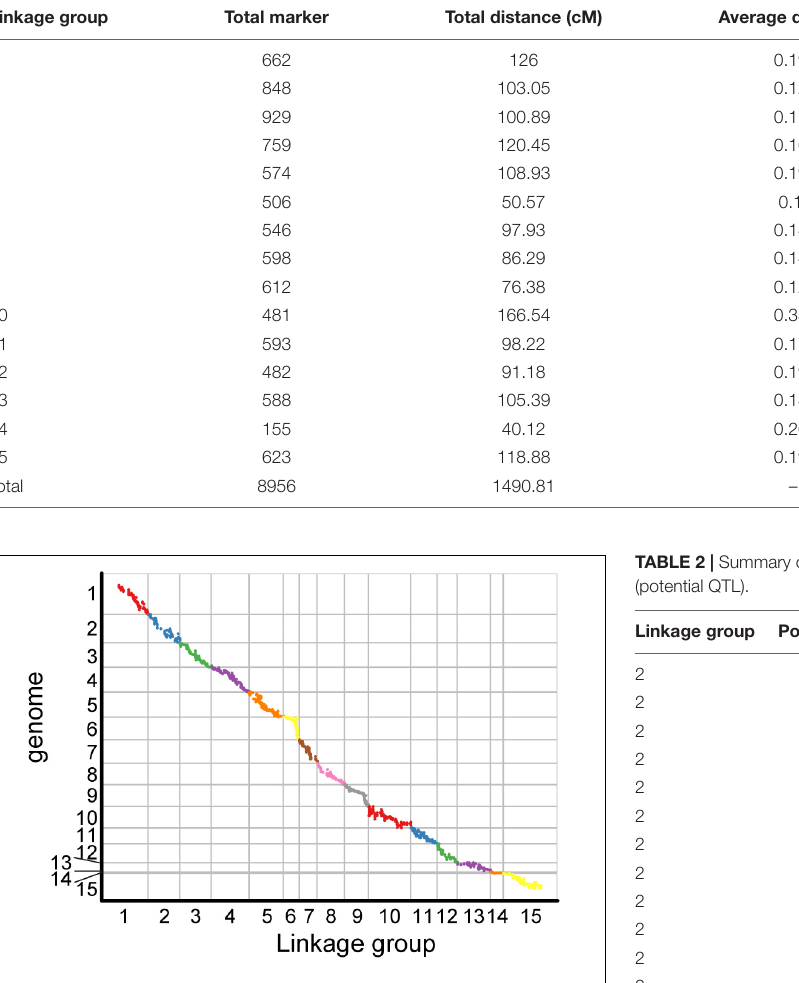
loci obtained from the GWAS were also located in second linkage group, and the significance test q values were 2.9E-8